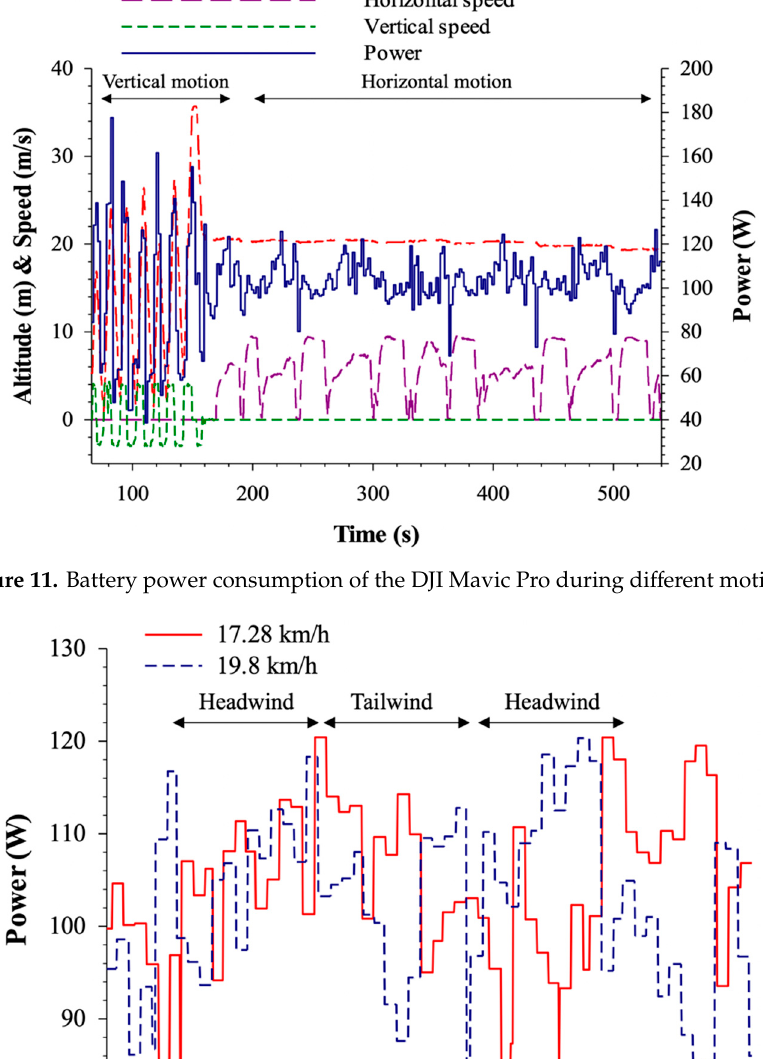
Figure 12. Battery power consumption of the DJI Mavic Pro under various wind conditions.